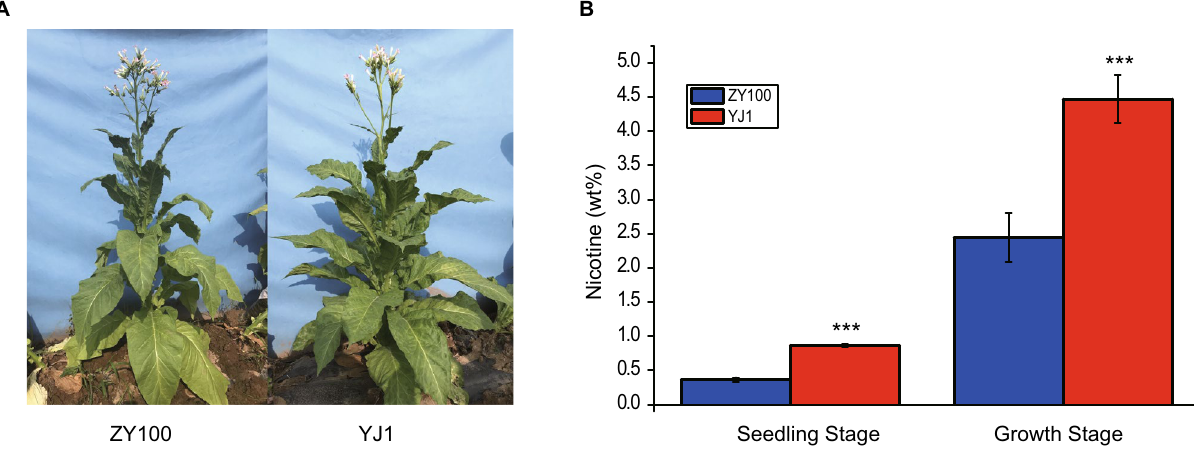
Figure 1. Phenotype for ZY100 and YJ1. ( A ) Phenotype for ZY100 and YJ1 at mature stage. ( B ) Nicotine level of leaves for ZY100 and YJ1 at different developmental